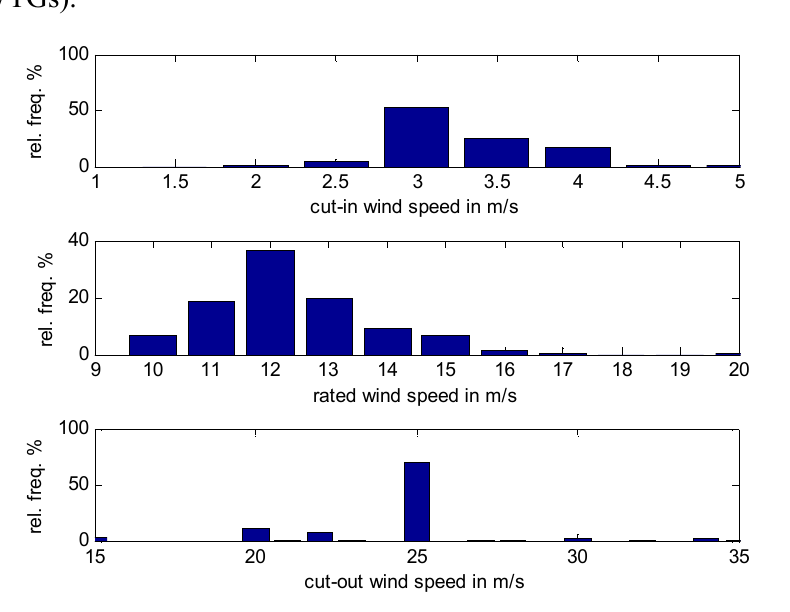
of 11 m/s and 15 m/s) and wind power r